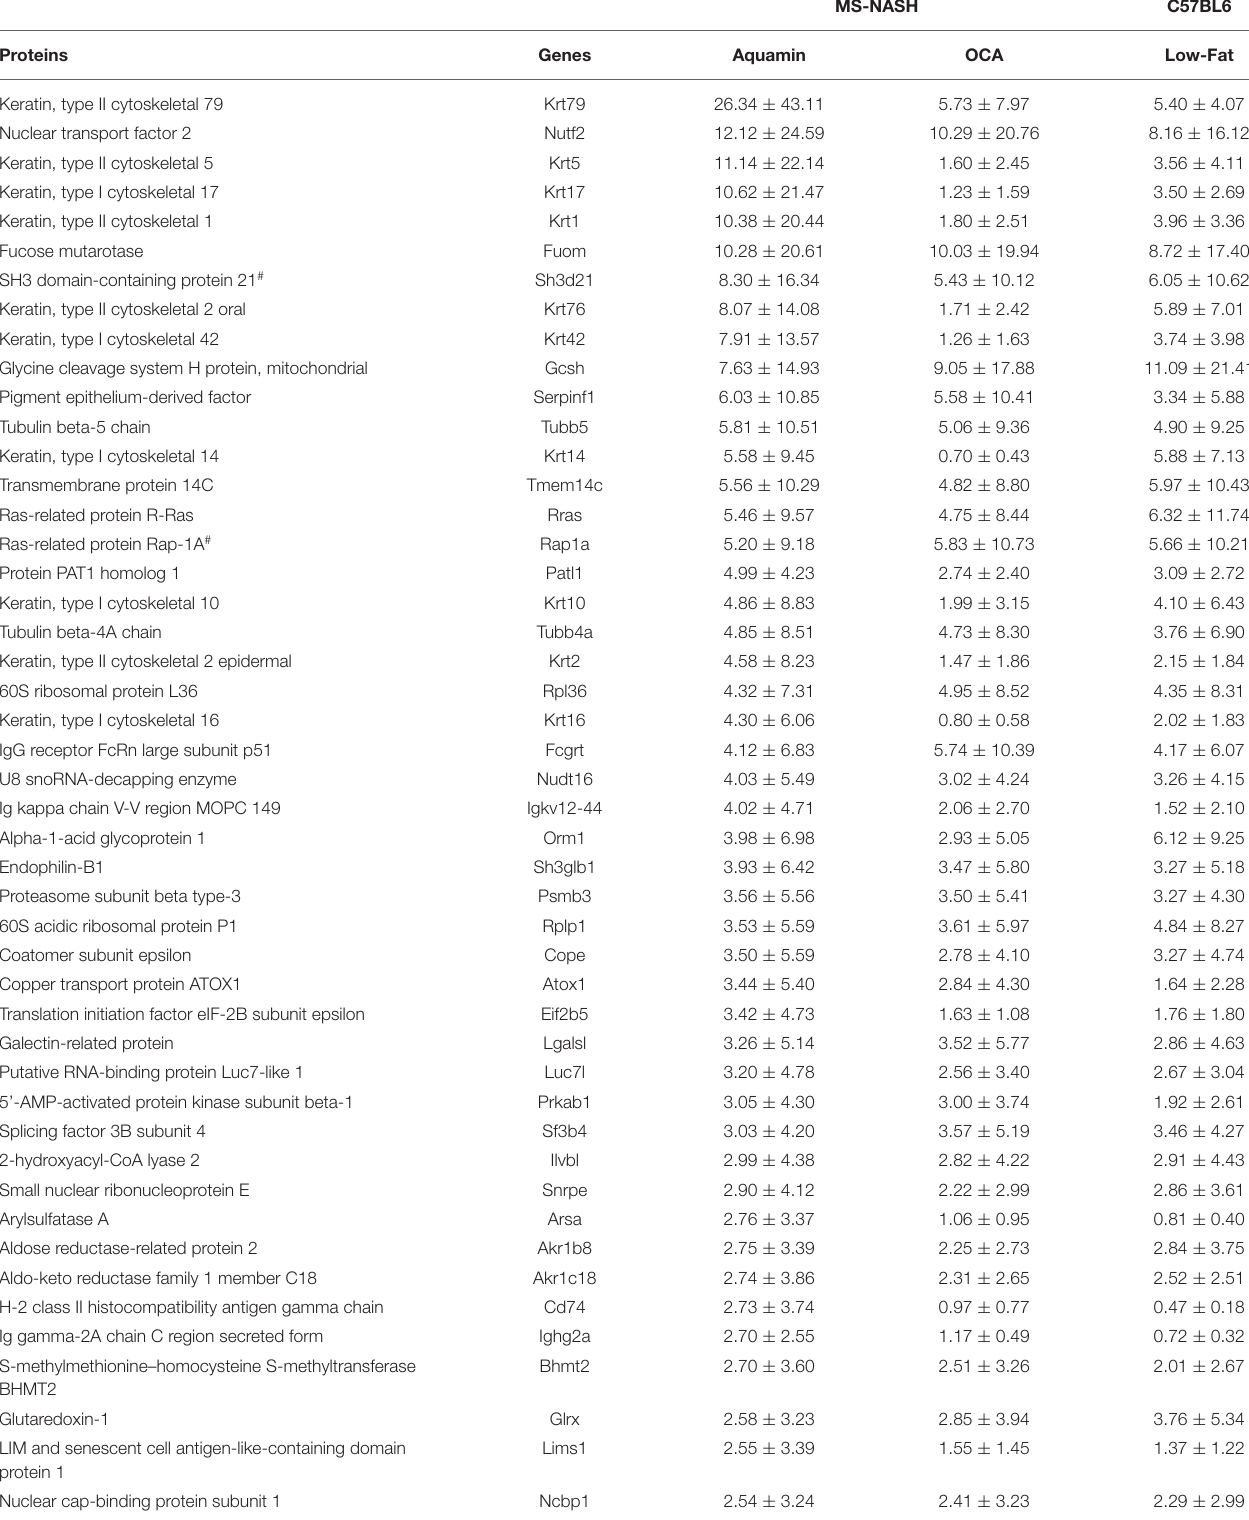
TABLE 2 | Upregulated proteins by an unbiased proteomic screening with Aquamin in high-fat